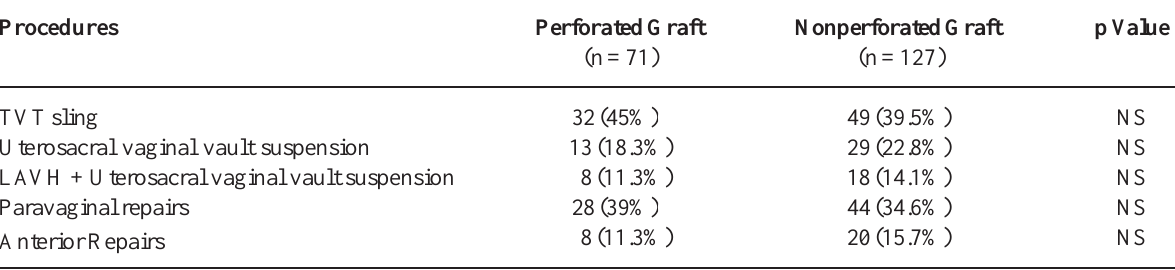
Table 1 – Additional procedures performed with posterior repairs.